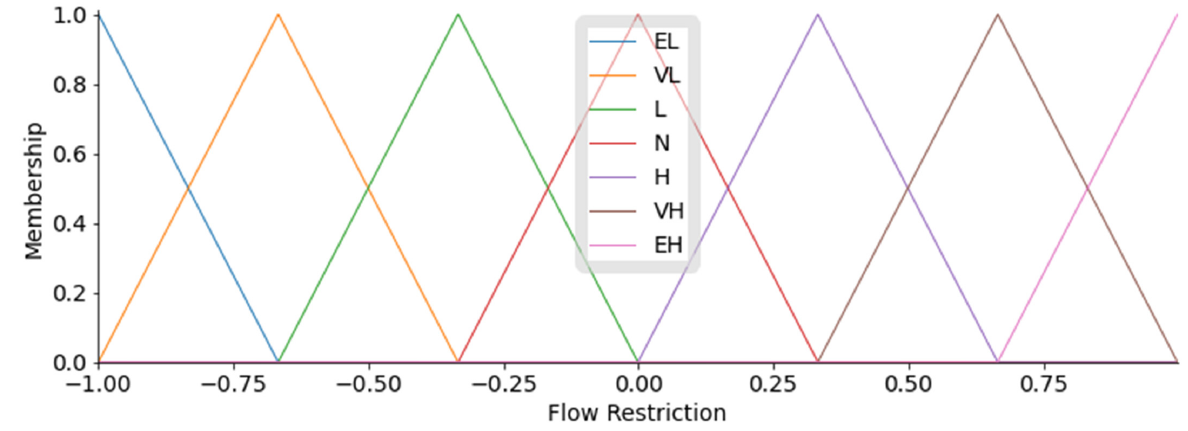
Figure 8. Graphical description of variable Flow Restriction. Table 5. Membership functions for variable Flow Restriction.